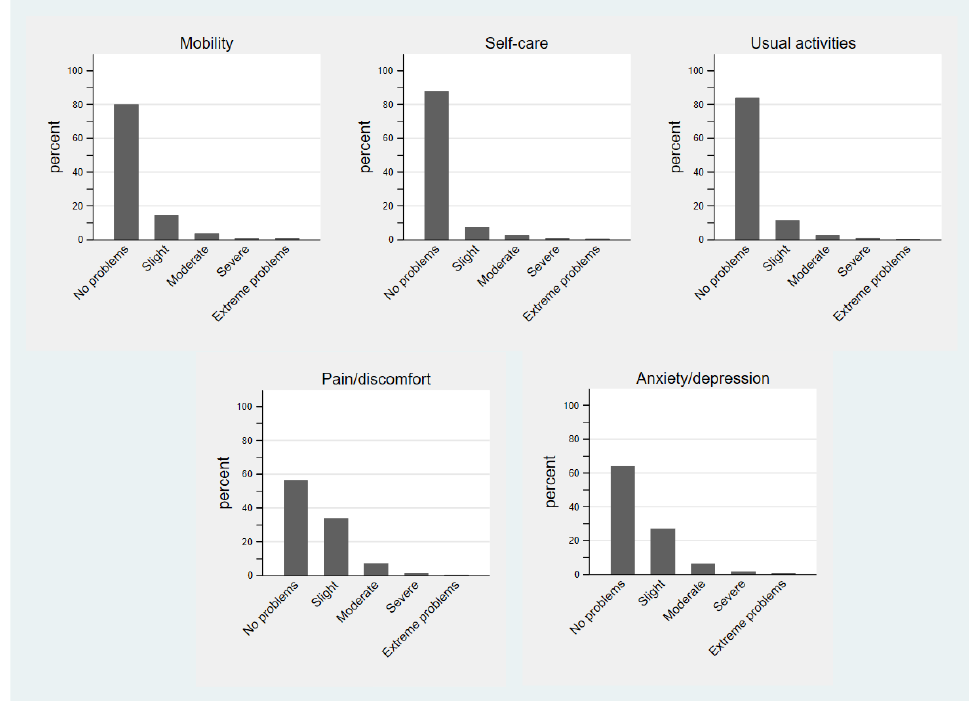
Figure 1. Dimensions of EQ-5D-5L for patients with chronic diseases. EQ-5D-5L, 5-level EQ-5D version.